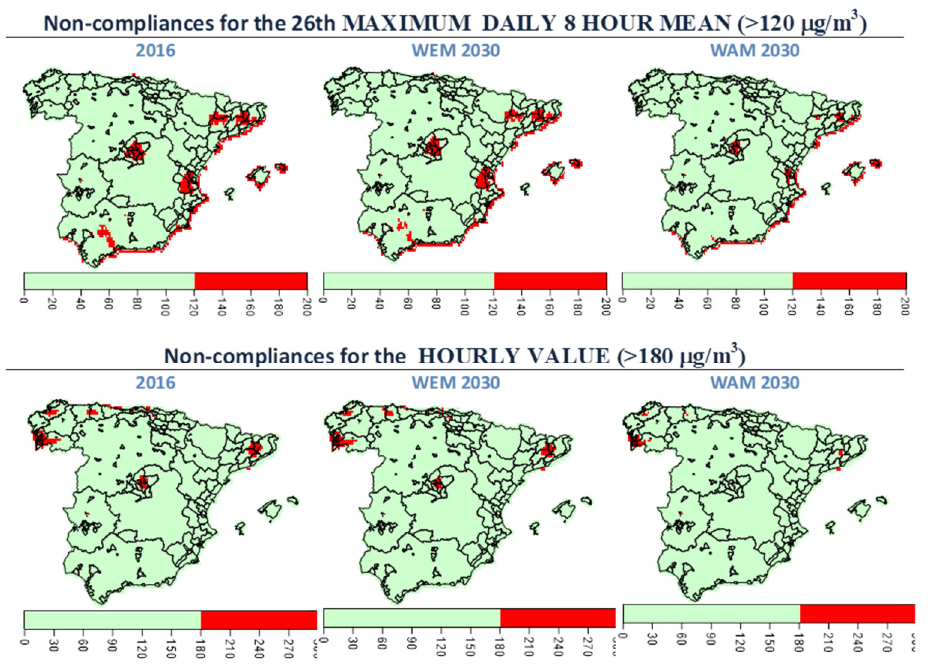
Figure 6. Maps ( µ g m − 3 ) showing the non-compliant grid cells estimated by the modeling approach for O 3 (daily maximum 8-hour value ( top ) and hourly values ( bottom )) and for 2016 (left); WEM2030 Figure 6. Maps (µg m −3 ) showing the non-compliant grid cells estimated by the modeling approach (middle); WAM2030 for O 3 (daily maximum 8-hour value (top) and hourly values (bottom)) and for 2016 (left); WEM2030 (middle); WAM2030 (right).